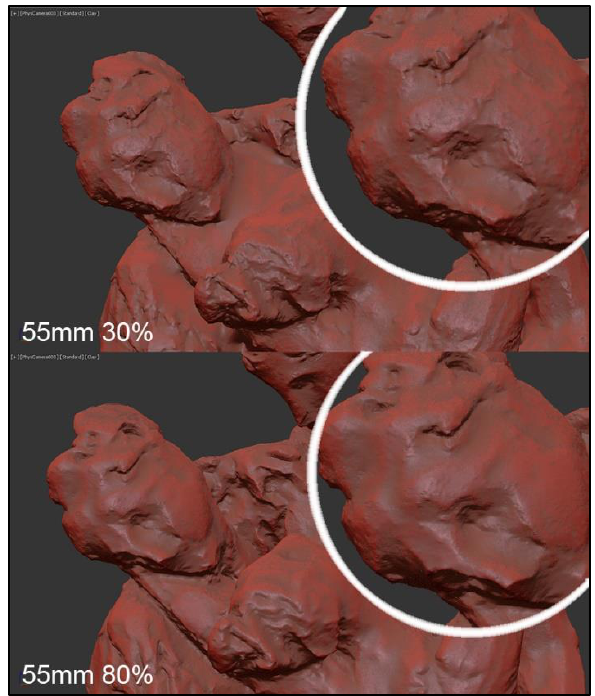
Figure 8. Quality comparison of 55mm at 30% and 80% image overlap